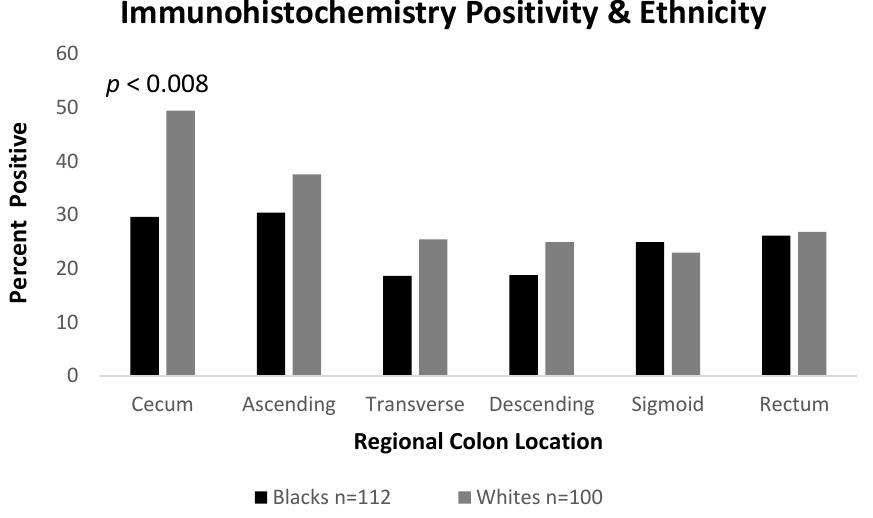
Figure 9. Bar Diagram showing reduced fixed p87 antigen in the ceca of AA, as compared to Cau- casians.